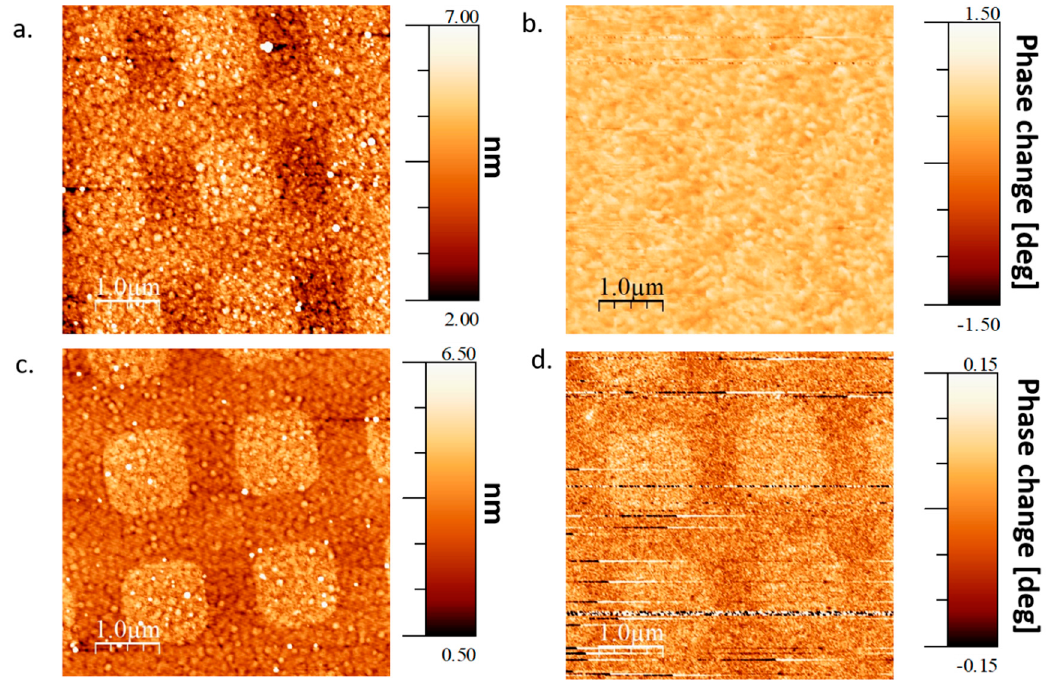
Figure 2. Topography and magnetization maps for L-AHPA SAM adsorption without applied external magnetic field. a . Topography of the SAM in IP easy axis wedge area. b . Magnetization phase of the SAM in IP easy axis Co wedge area. c . Topography of the SAM in OoP easy axis wedge area. d . Magnetization phase of the SAM in OoP easy axis wedge area. It is clear that there is a perpendicular magnetization component in the OoP easy axis wedge areas while it is absent in the IP region.